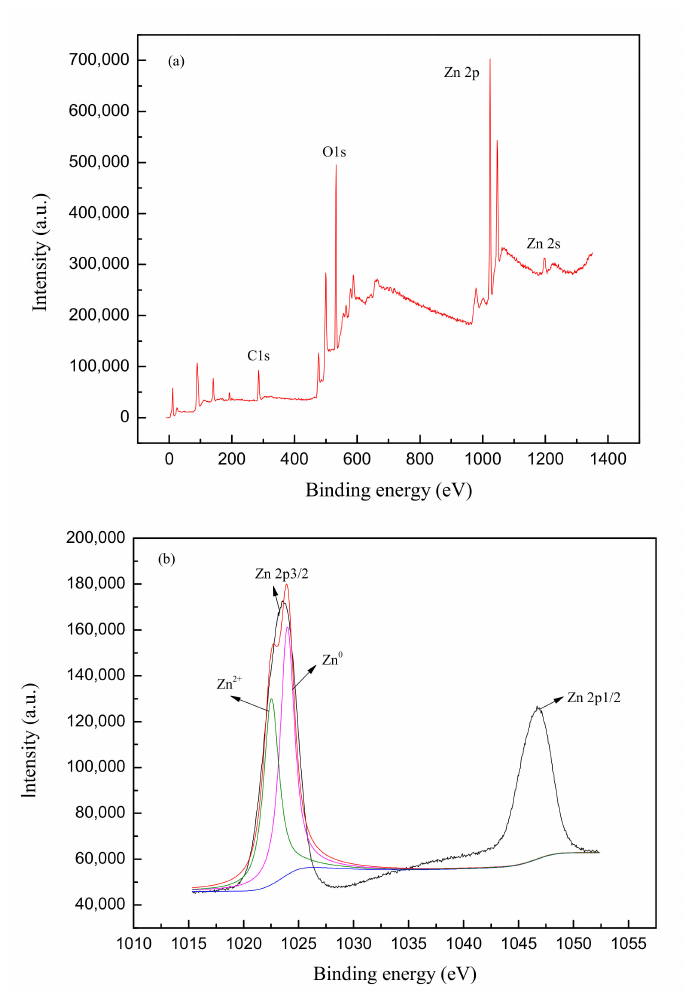
Figure 7. The X-ray photoelectron spectroscopy (XPS) spectra of nZVZ ( a ); The XPS spectra of the Zn-2p core level. Regions ( b